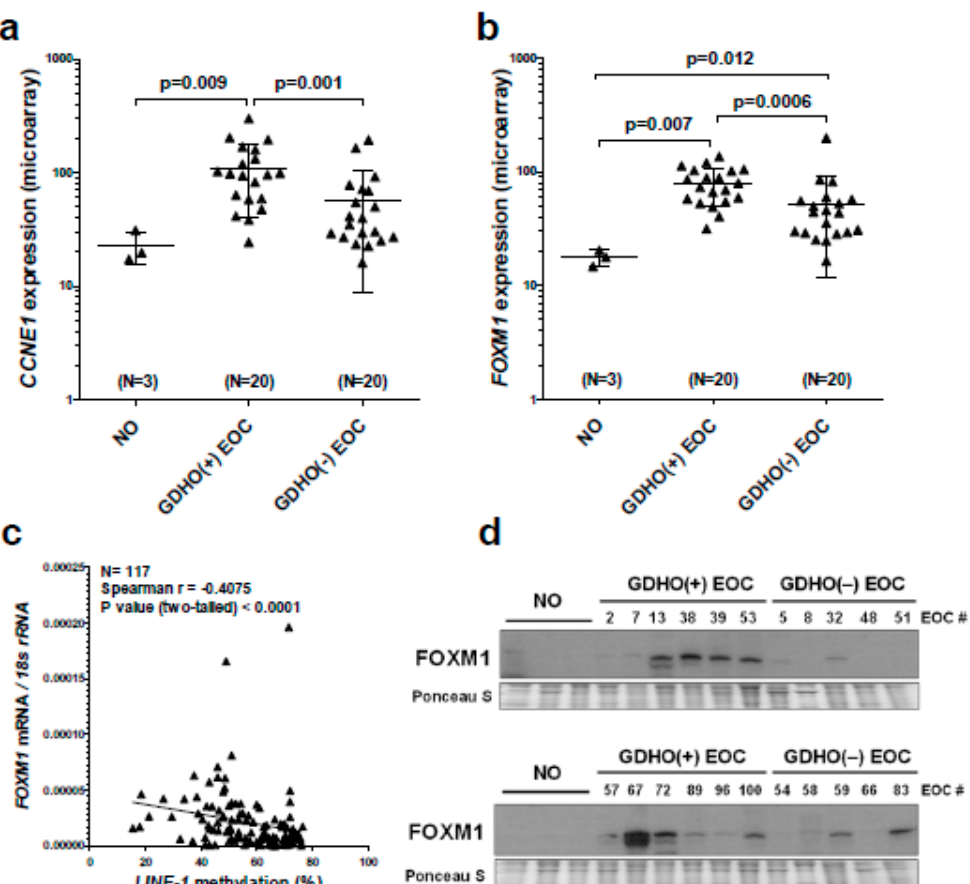
Figure 3. CCNE1 and FOXM1 are overexpressed in GDHO ( + ) EOC. ( a ) CCNE1 expression in NO, GDHO ( + ) EOC, and GDHO (–) EOC, determined by A ff ymetrix microarray. ( b ) FOXM1 expression in NO, GDHO ( + ) EOC, and GDHO (–) EOC, determined by A ff ymetrix microarray. Means ± SD are plotted, and Mann–Whitney p-values are indicated. ( c ) FOXM1 mRNA expression vs. LINE-1 methylation in an expanded set of EOC tumor samples. FOXM1 expression was measured by RT-qPCR and LINE-1 methylation was measured by pyrosequencing. Spearman test results and p-value are shown. ( d ) Western blot analysis of FOXM1 protein expression in NO, GDHO ( + ) EOC, and GDHO (–) EOC. The upper and lower blots are comprised of di ff erent sets of samples. Ponceau S staining is shown as a loading control.